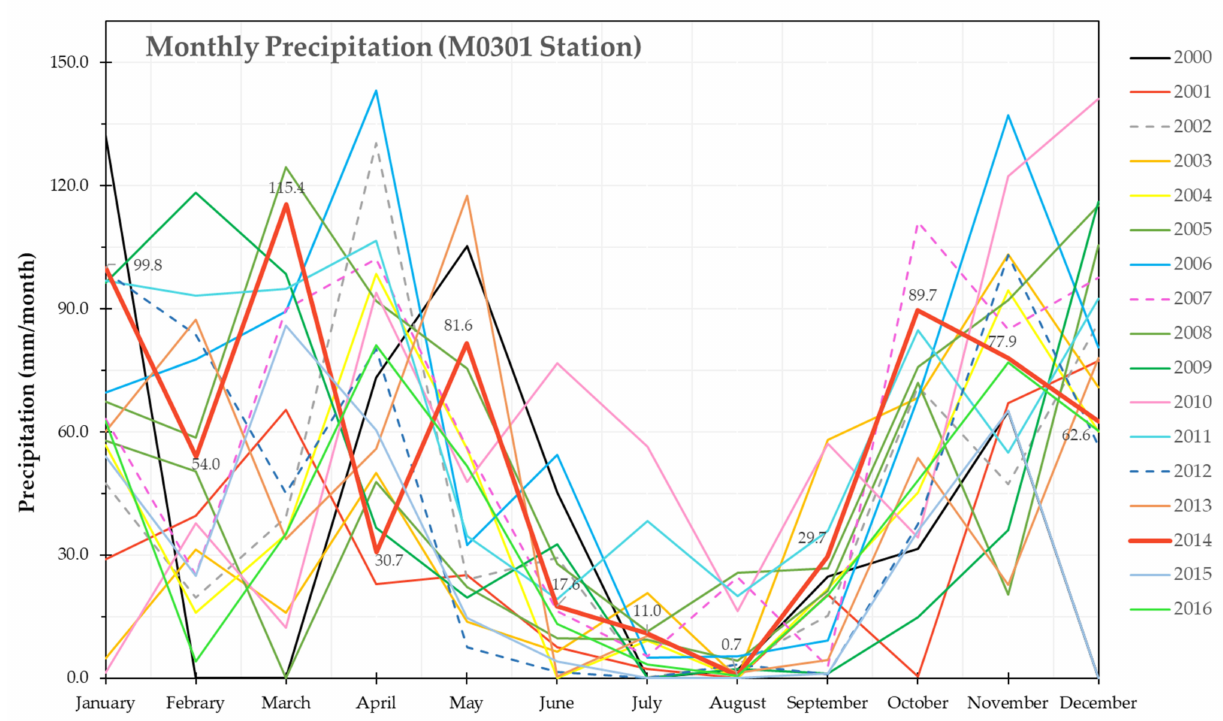
Figure 11. Hydrograph of the Carchi meteorological station (M0301) in 2000–2016.